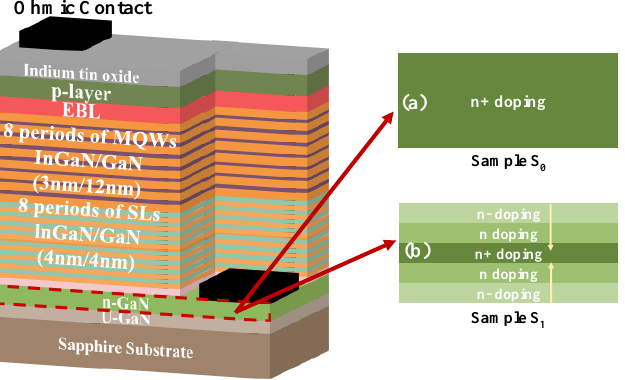
Figure 1. Schematic diagrams of ( a ) the reference device (Sample S 0 ) and ( b ) the proposed device with stair-like Si-doping GaN layer (Sample S 1 ).